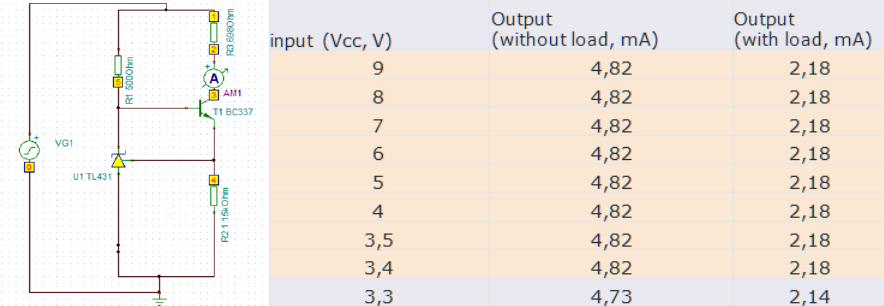
Figure 2. LED needs a constant current to emit a well-defined light. ( Left ): Circuit diagram of the used electronic. ( Right ): Test results with and without load. Constant current can be guaranteed for a wide range of input